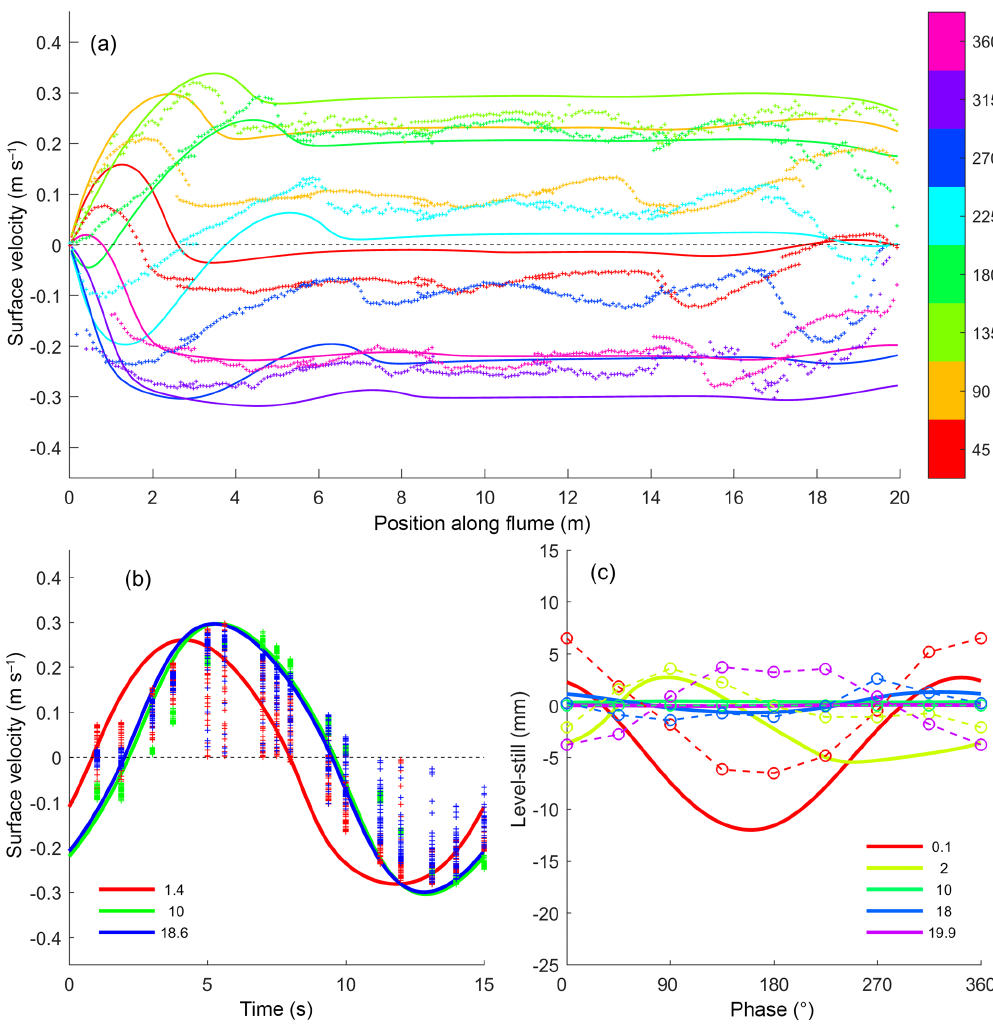
Figure 10. Flow data from PIV and modelled flow with 15s period tilting at 0.009mm − 1 slope amplitude with upstream boundary closed. (a) Flow velocity at the water surface along the flume for selected phases of the tidal cycle. (b) Flow velocity at the water surface in one tidal cycle for selected positions along the flume measured from x = 0m, indicated in the legend. (c) Water level as a function of phase in the tidal cycle for selected positions along the flume. Measured water levels have correct amplitude and phase but possibly erroneous vertical offsets. Data are plotted as symbols and model results are plotted as drawn